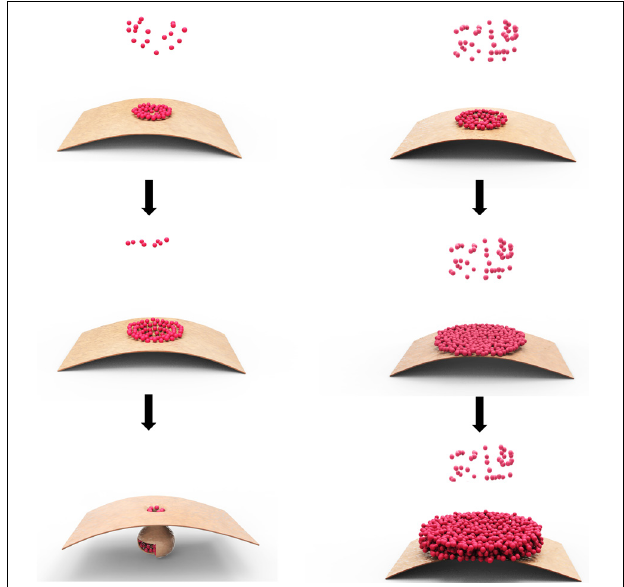
FIGURE 2 | Model of p28 polymerization at different intracellular concentrations. The small dots represent monomeric p28, whereas the bent sheet represents a section of mitochondrial outer membrane. The left column depicts the situation when p28 concentration is relatively low, causing self-limited polymerization of small lattice on the surface of mitochondrial membrane, which eventually becomes enclosed through membrane curving and invagination. The right column depicts the situation when p28 concentration is high; causing the polymerization to proceed swiftly and the lattice expands quickly, making it impossible to become enclosed by mitochondrial membrane. The exposed lattice, or possibly its multi-layered derivatives, could indefinitely recruit new p28 monomers, blocking them from engaging in